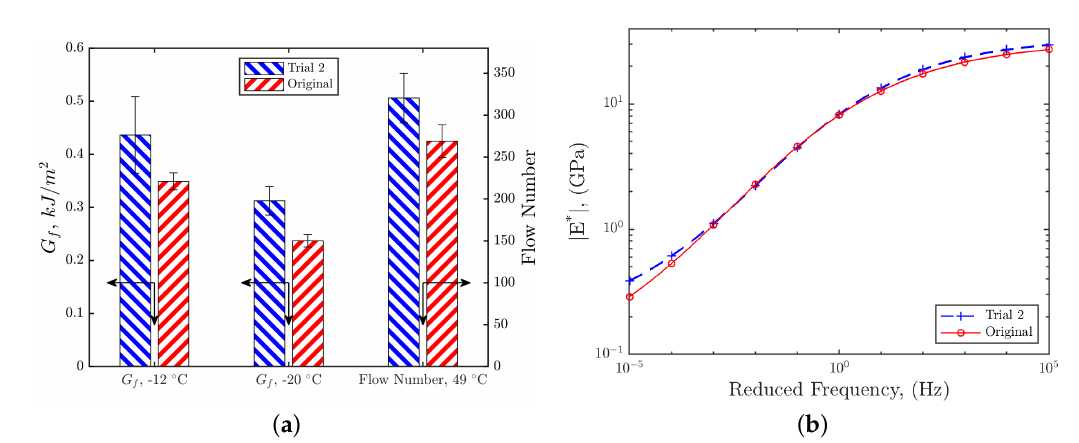
Figure 5. Performance tests results of the original and modified mixtures. ( a ) SCB fracture energy and flow number results. The error bar indicates the standard error of three replicates. The arrows indicate the corresponding axes for the data. ( b ) Dynamic modulus master curves where the reference temperature is 12 ◦ C.